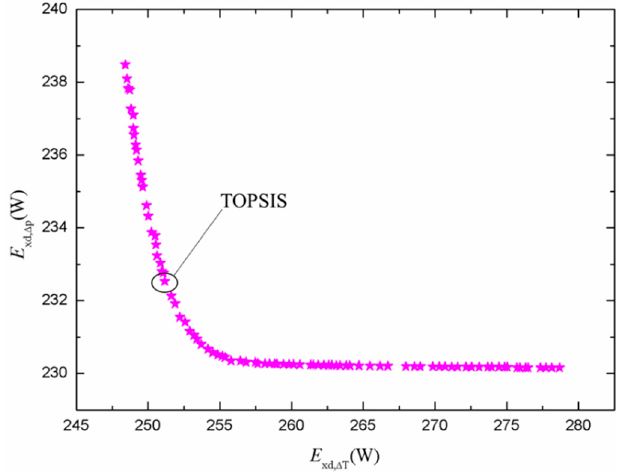
Figure 21. Pareto Figure 21. Pareto front. Figure 21. Pareto front.